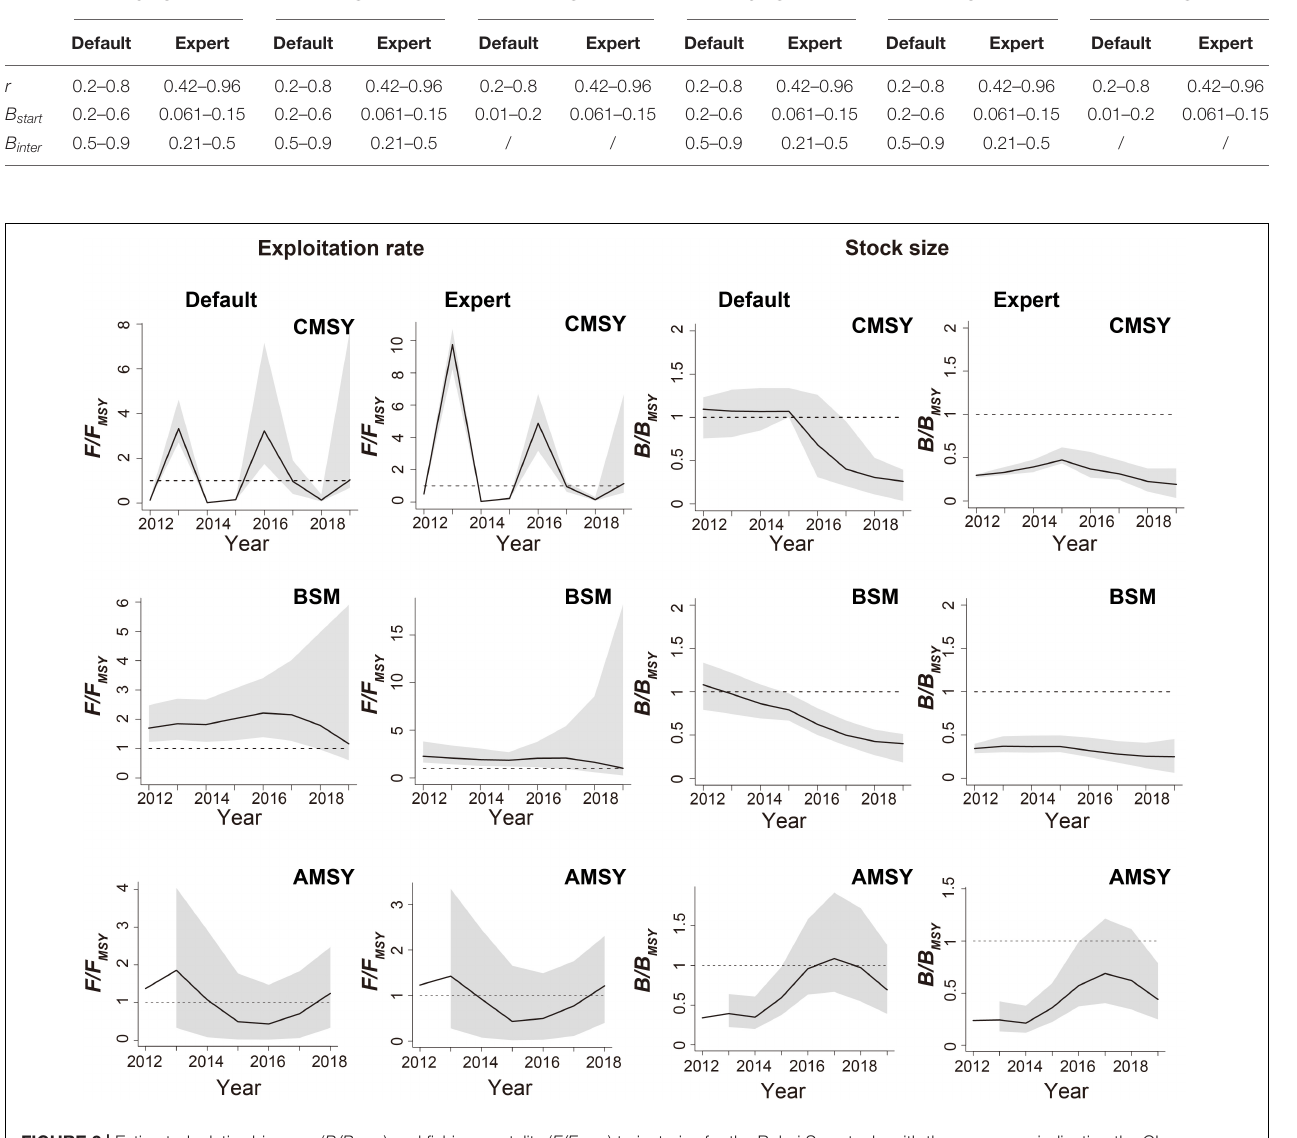
FIGURE 2 | Estimated relative biomass ( B/B MSY ) and fishing mortality ( F/F MSY ) trajectories for the Bohai Sea stock, with the gray areas indicating the